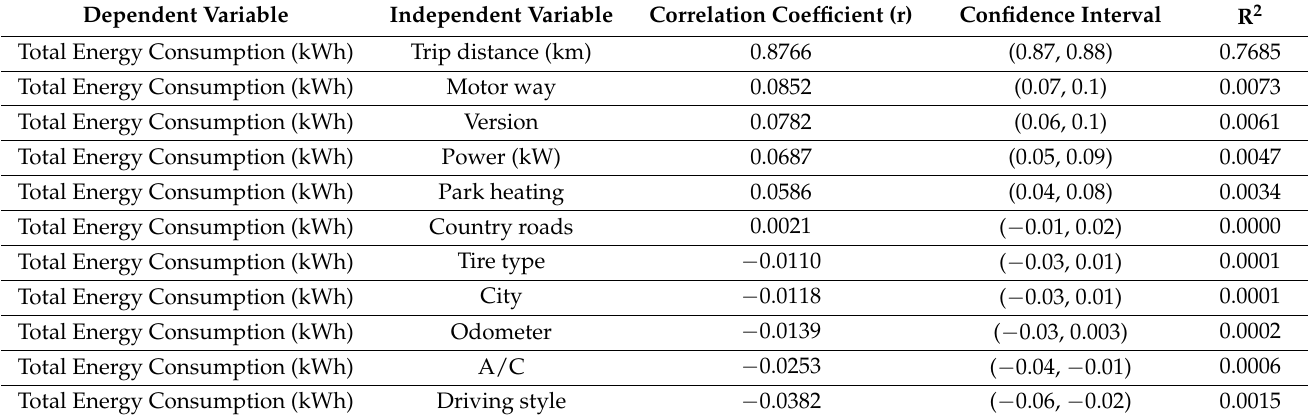
Table 2. Pairwise correlation analysis between each independent variable and the dependent